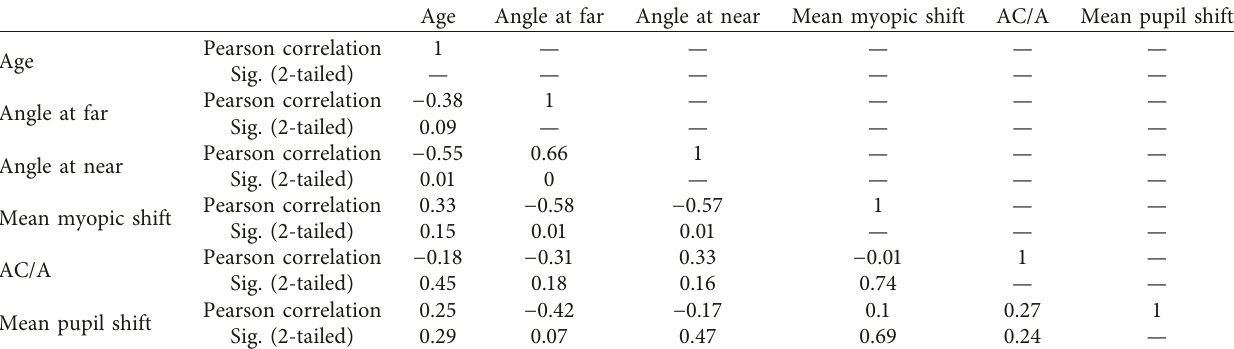
Table 3: Group B: Pearson